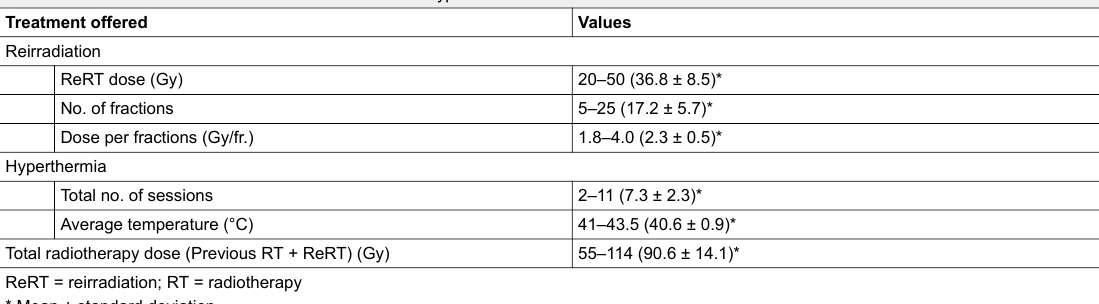
Table 2: Retreatment offered with reirradiation and local